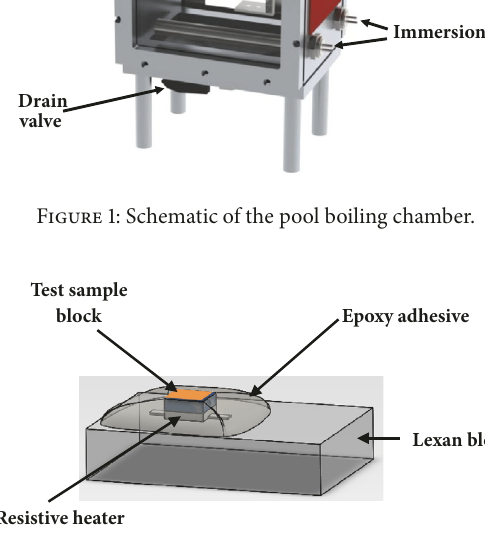
Figure 2: Schematic of test heater